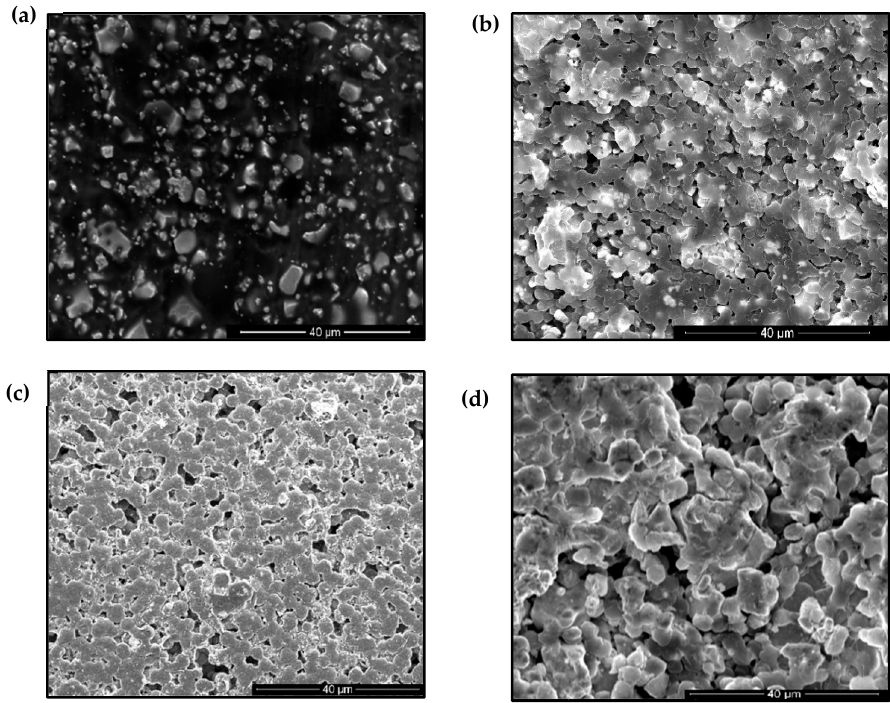
Figure 5. SEM images with different PVDF/ PZT concentrations: ( a ) 20:80; ( b ) 40:60; ( c ) 60:40; ( d ) 80:20.